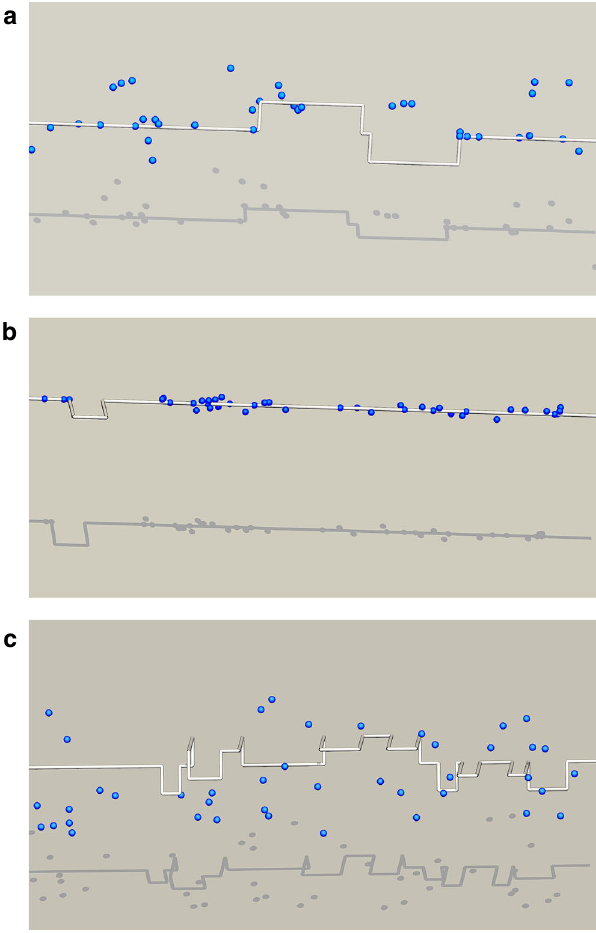
Simulation snapshots corresponding to the three dynamic scenarios described in the text. a Solute diffusion occurs over timescales much shorter than kink-pair nucleation, making both processes effectively decoupled. b The oxygen atoms segregate at the dislocation core, temporarily trapping it before the dislocation can release itself and produce a strain burst. c No solute motion is observed, and the dislocation moves in a static interstitial solid solution, developing more kink pairs and cross- kinks. The length of line captured in all three panels is approximately 100 b . As it can be appreciated, the density and width of the kink pairs shown in the fi gures is markedly different from case to